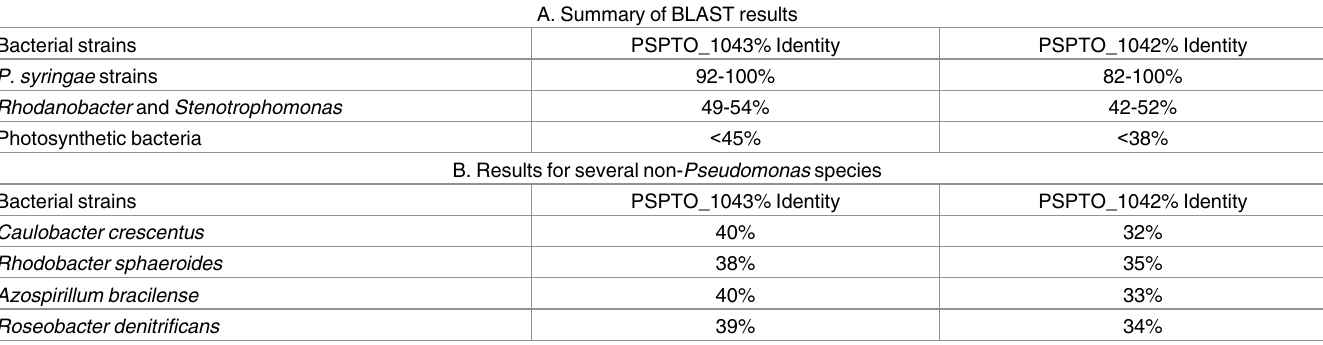
Table 1. Distribution of